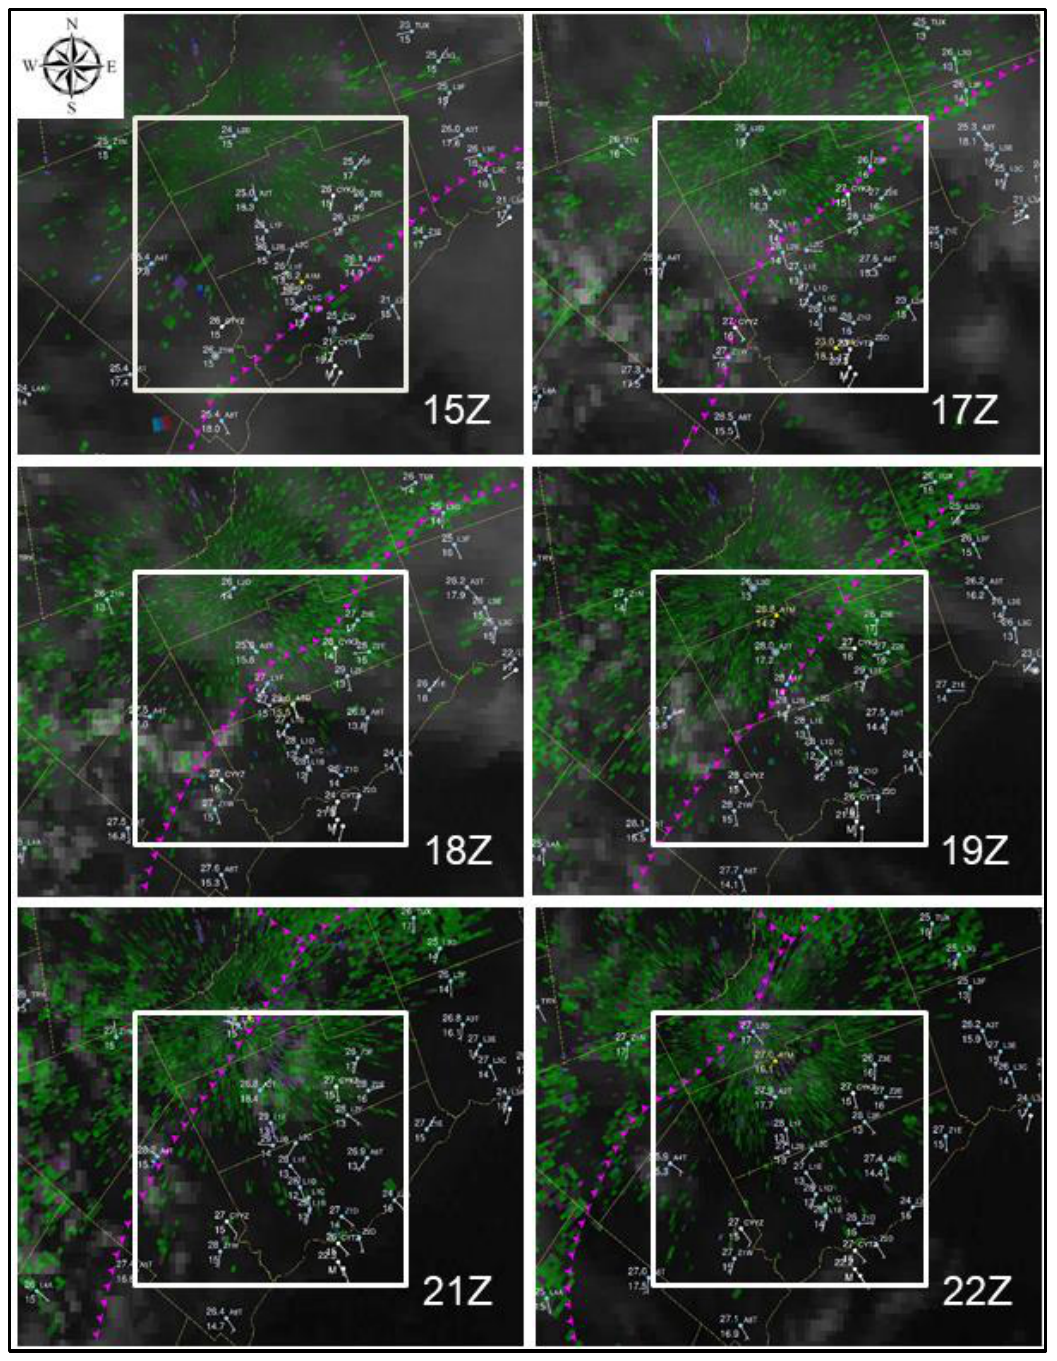
Figure 19. Mesoscale meteorological analysis for 12 July 2015. The box highlights the same region as Figure 18. Wind barbs report 10-m station data. The purple front is the observation-derived lake breeze front.